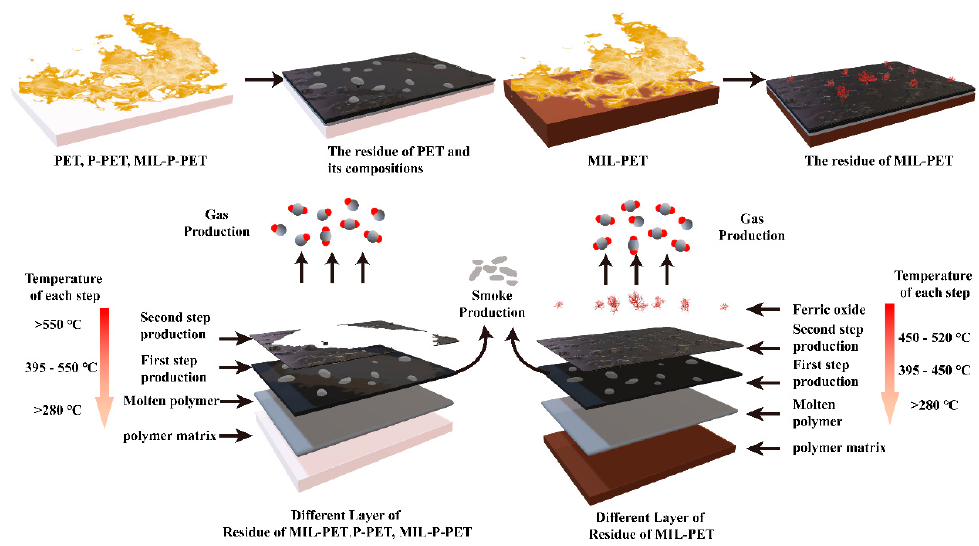
Figure 14. The possible carbonization mechanism for MIL − PET and MIL − P − PET.